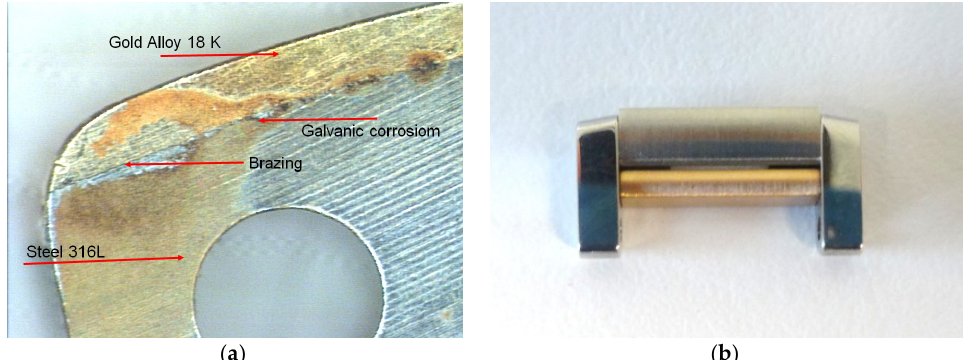
Figure 1. ( a ) Steel–brazing–gold 18K. ( b ) Link gold 18K-steel with